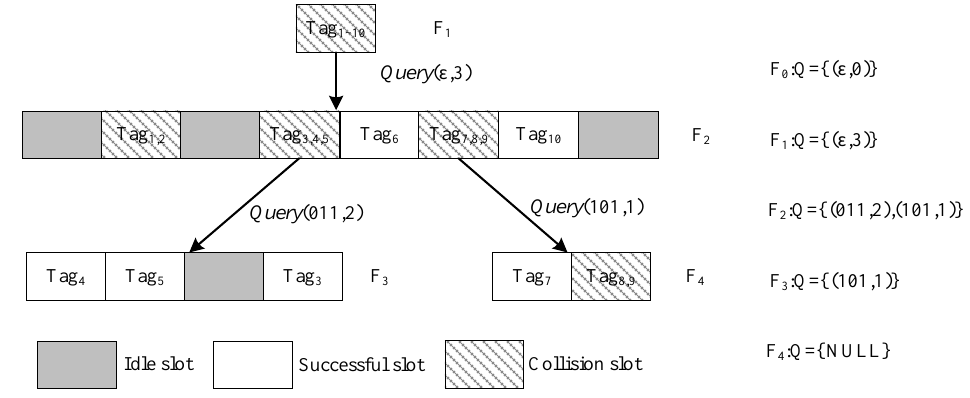
Figure 7. Example of DQTR recognition